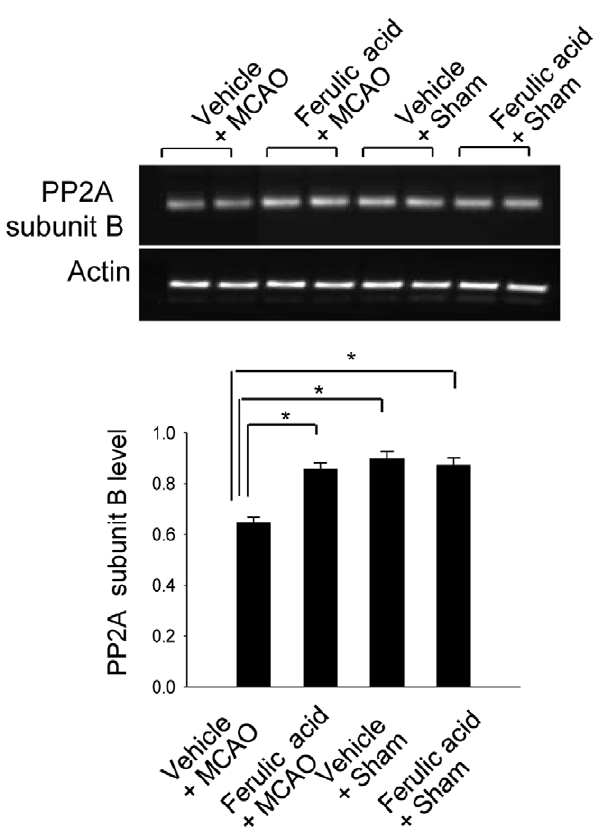
Figure 3. The change of protein phosphatase 2A (PP2A) subunit B protein mRNA by ferulic acid in focal cerebral ischemia. RT-PCR analysis of protein phosphatase 2A (PP2A) subunit B in the cerebral cortices from vehicle + MCAO, ferulic acid + MCAO, vehicle + sham, ferulic acid + sham animals. Animals were treated with vehicle or ferulic acid prior to MCAO. Each lane represents an individual experimental animal. Densitometric analysis is represented as intensity of PP2A subunit B to intensity of actin. Data ( n =5) are represented as mean 6 S.E.M. * P , 0.05.